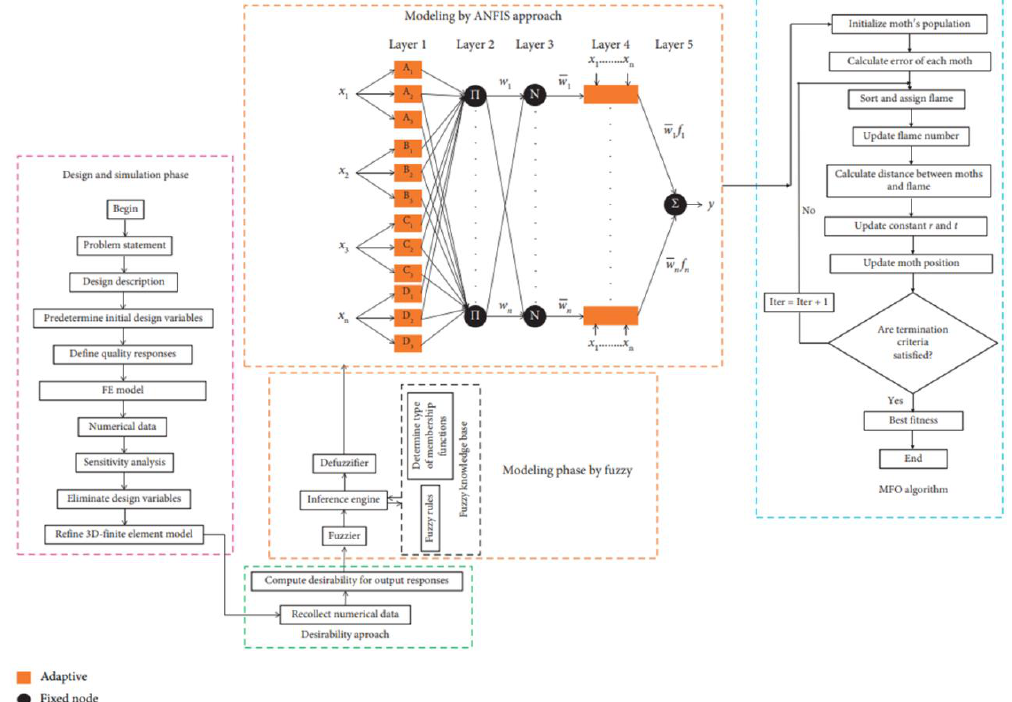
Figure 14. Data driven design approach flowchart using ANFIS [114].